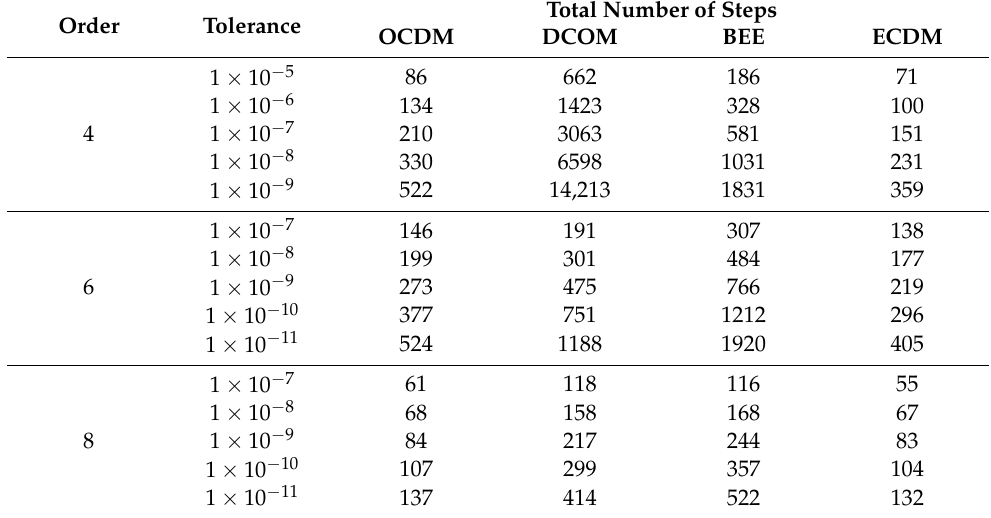
Table 3. Dependence between the total number of steps and tolerance while solving Rössler problem.